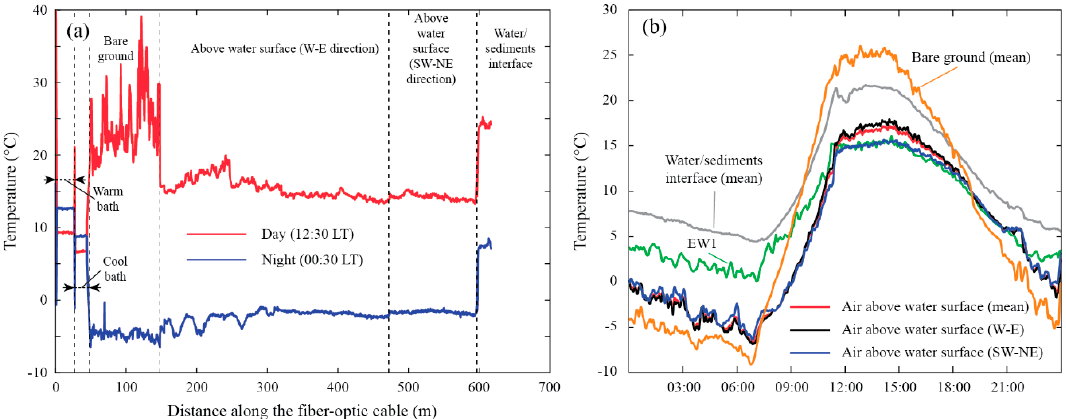
Figure 8. ( a ) DTS data that shows representative thermal profiles along the optical fiber for day- and night-time. The warm and cool bath are sections along the cable used for calibration purposes. ( b ) Temperatures measured with the EW1 meteorological station and the DTS system (17 November 2018). The DTS temperatures shown correspond to the mean values of the di ff erent sections depicted in Figure 8a, and are integrated over 5-min to have the same time interval than the records of the EW1 meteorological station.